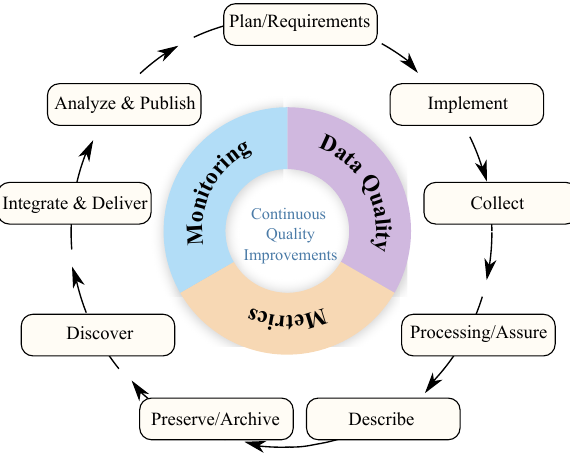
Figure 5. ARM adapted Data management life-cycle.